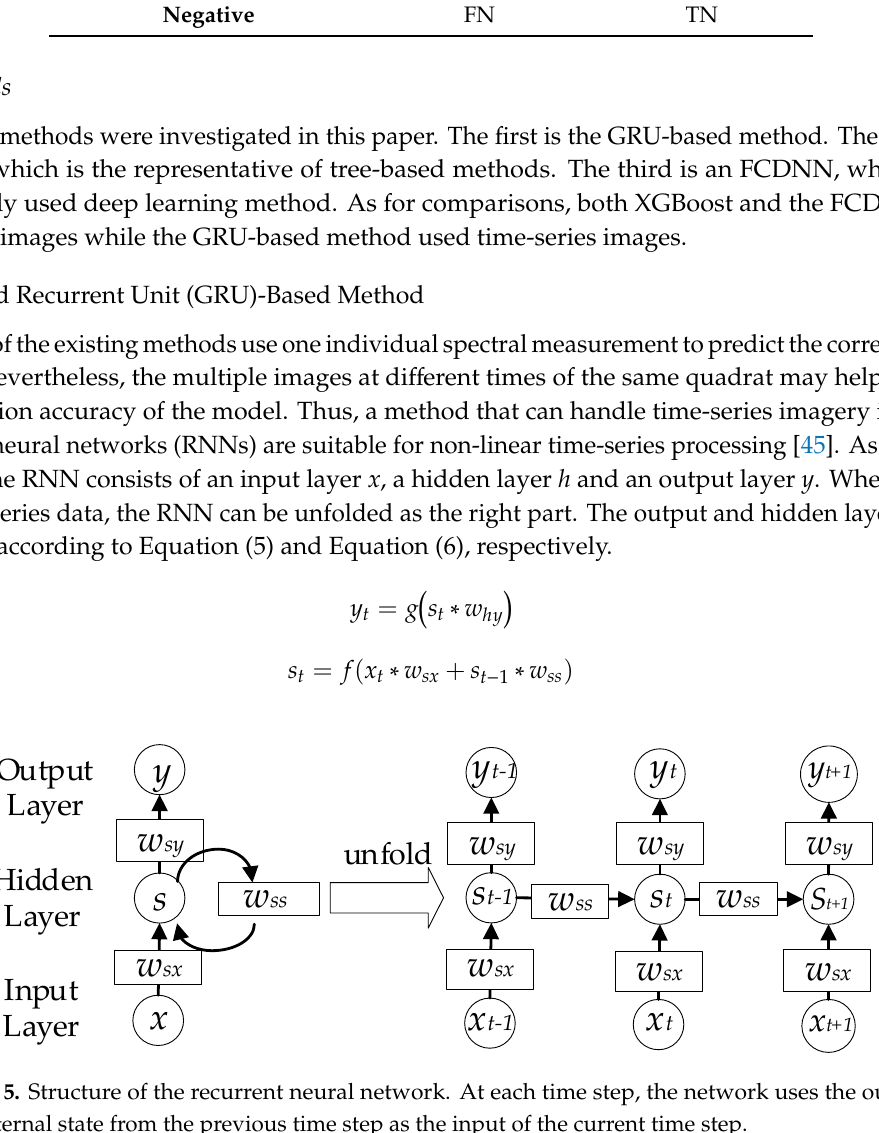
Table 1. Definitions of true positive (TP), false positive (FP), true negative (TN) and false negative (FN).